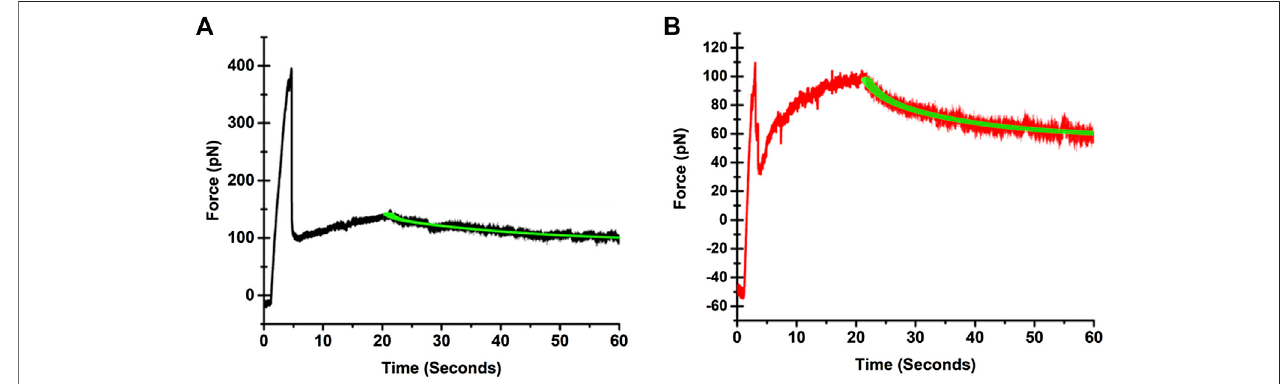
FIGURE 2 | Illustrative force pro fi les associated with tethers pulled from (A) IOSE364, and (B) SKOV3 cells. The black trace for the IOSE364 cell, and the red trace fortheSKOV3cellarethemeasuredforcepro fi les.Thebiphasicexponential fi tstotheforcerelaxationmeasurementsareshownbythegreentraces.Theexpressionsfor the fi ts are F ( t ) (cid:1) 95 . 0 + 37 . 5 e − ( t 24 . 0 ) + 7 . 5 e − ( t 2 . 7 ) for the IOSE364 cell, and F ( t ) (cid:1) 56 . 4 + 31 . 5 e − ( t 17 . 2 ) + 10 . 4 e − ( t 2 . 2 ) for the SKOV3 cell.